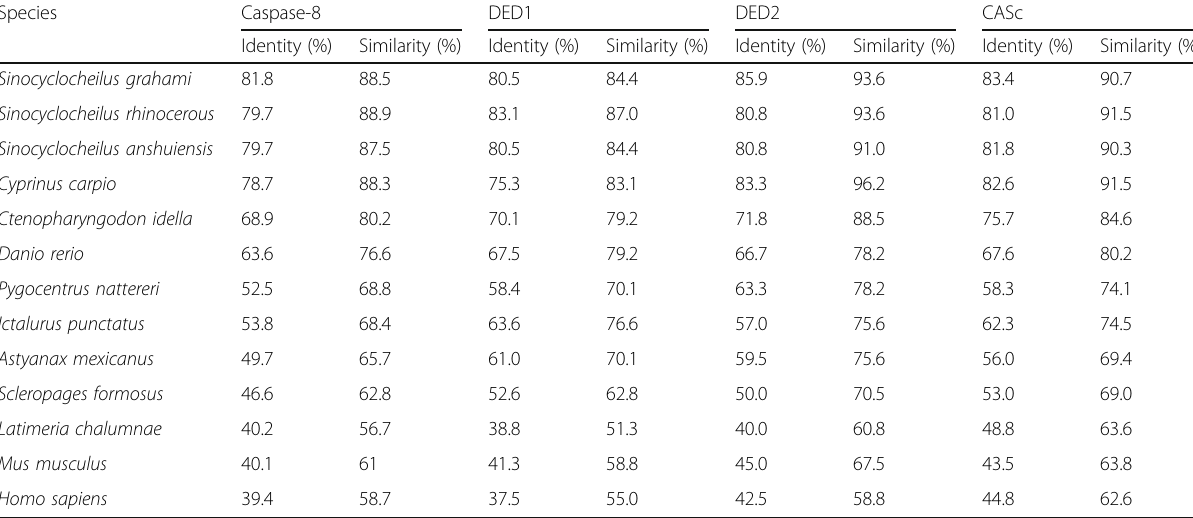
Table 2 Similarity and identity of amino acids in Lrcasp8 and its domains with other fish and animal species caspase-8